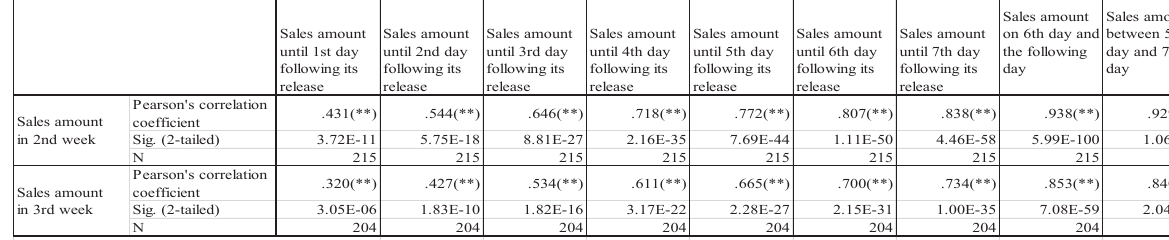
Fig. 4. Detail of learning process. Table 2. Correlation coefficient between the sales amounts in the second, third selling week and the number of days on